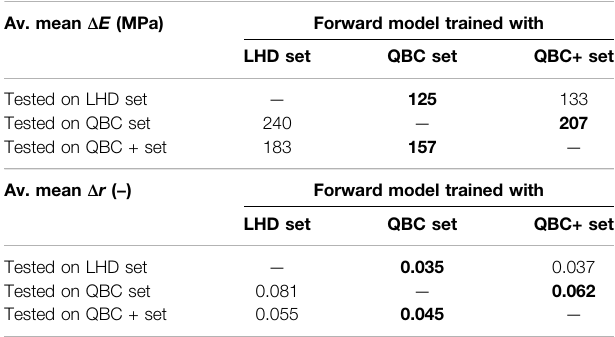
TABLE 2| Averagemean Δ E and Δ r fortheneuralnetworkstrainedand evaluated on the three generated data sets: LHD (Latin hypercube design), QBC (query- by-committee) and QBC+ (query-by-committee with extension). The best result for each test set is marked in bold. Av. mean Δ E